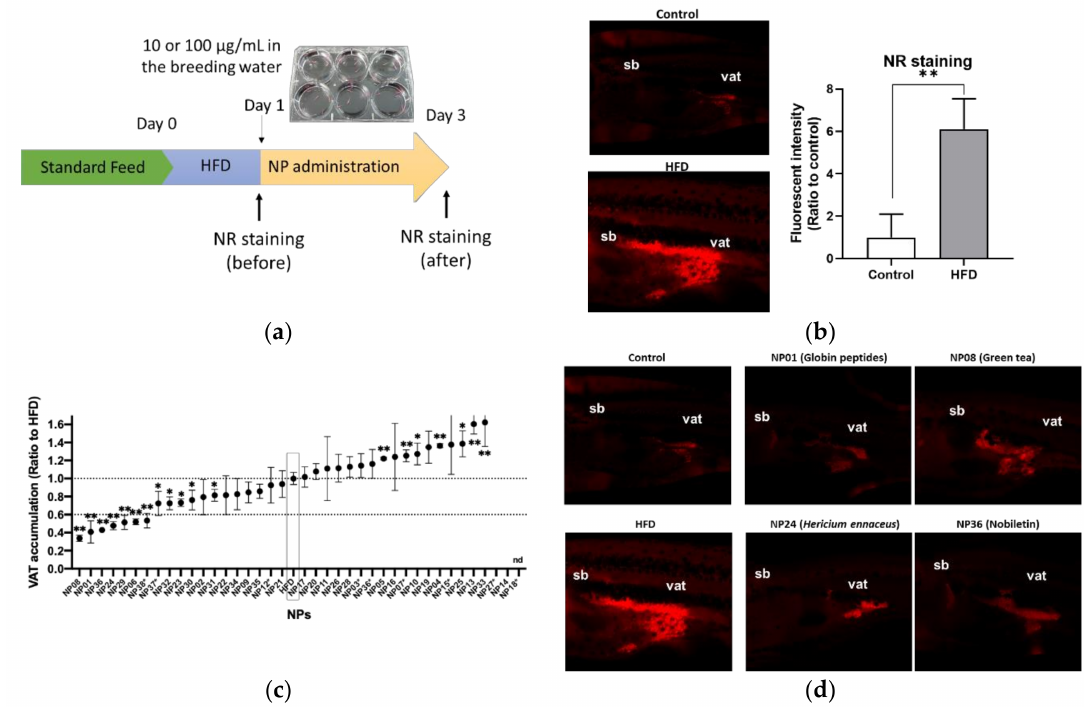
Figure 1. Zebrafish obesogenic test (ZOT) identifies seven anti-obese natural products (NPs). ( a ) Experimental design for ZOT. ( b ) Short term high-fat diet (HFD) increased the amount of visceral adipose tissue (VAT). Right panel indicates typical images of the control and HFD groups. Red indicates Nile Red (NR)-stained VAT. sb; swimming bladder, vat; visceral adipose tissue. Left panel indicates quantification of NR stained area. Values presented are means. Error bars indicate SD. n = 5, ** p < 0.01, Student’s t-test. ( c ) ZOT result. Dotted lines indicate 1 and 0.6 ratio to HFD alone group (HFD). NPs with asterisks were administered at lower volumes (10 µ g / mL) because of their toxicity. The others were administered at 100 µ g / mL in the breeding water. Values presented are means. Error bars indicate SD. n = 5–10, * p < 0.05, ** p < 0.01 vs. control, one-way ANOVA with Bonferroni–Dunn multiple comparison. nd indicates not determined because of high toxicity (NP18). ( d ) Typical image of e ff ective NPs in ( c